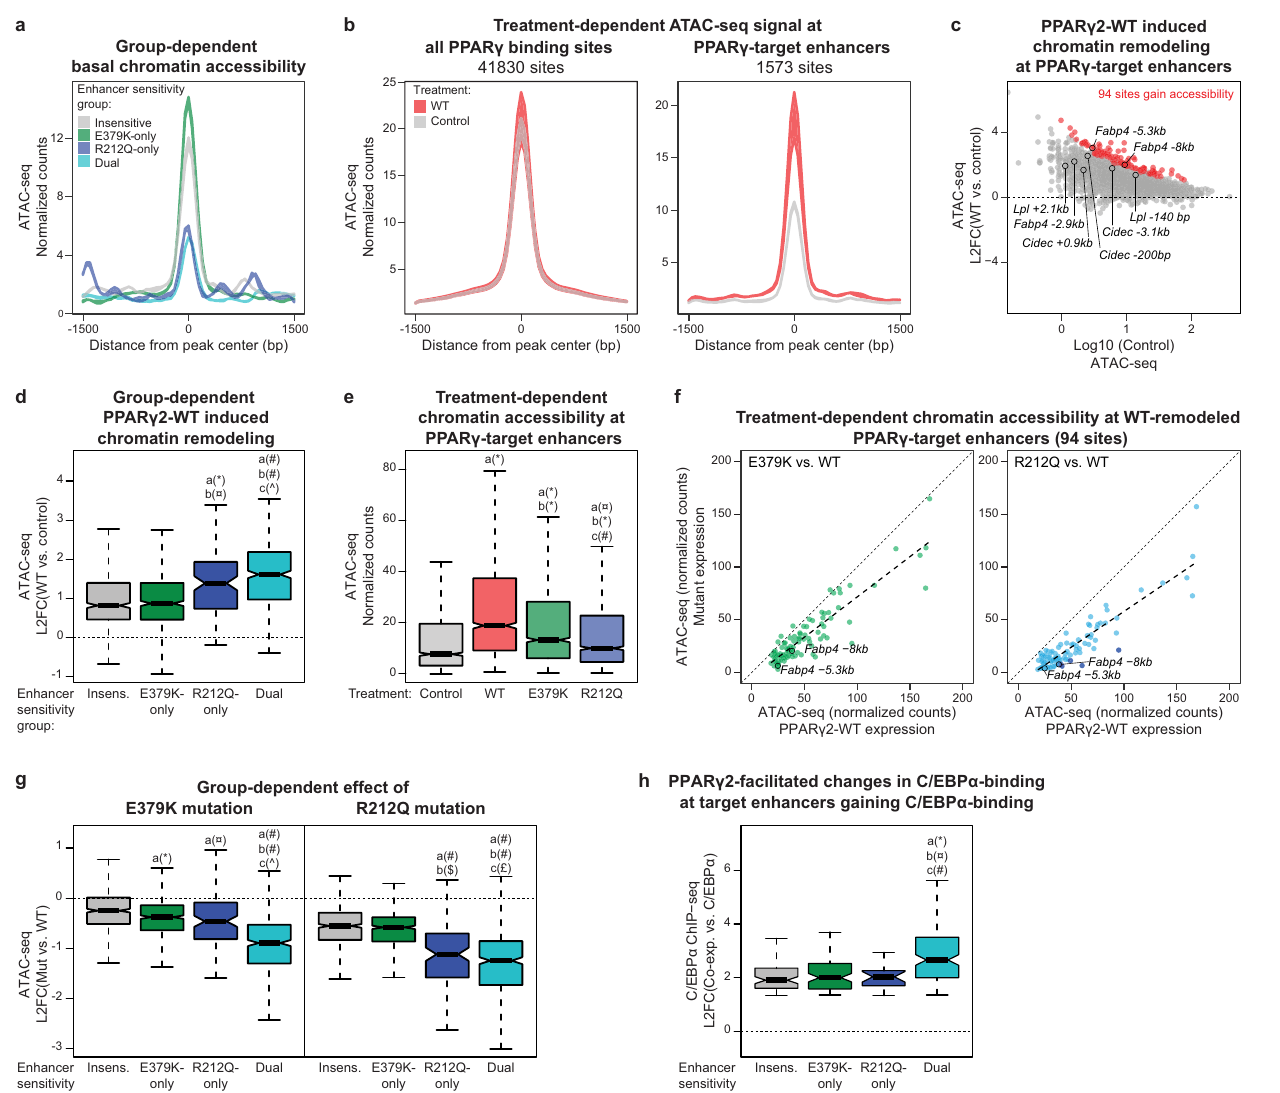
Fig. 8 | R212Q-sensitive enhancers are found in less accessible regions of the chromatin.a Enhancergroup-dependentATAC-seqsignalincontrolcells.Colored arearepresentsthedifferencebetweenthetworeplicates. b Treatment-dependent ATAC-seq signal from control and PPAR γ 2-WT expressing PPAR γ − / − MEF-CAR cells on all PPAR γ binding sites (left) or PPAR γ -target enhancers (right). Colored area represents the difference between the two replicates. c MA-plot of PPAR γ 2-WT induced chromatin accessibility at PPAR γ -target enhancers (L2FC, log2 fold change). Gained accessibility is de fi ned using DESeq2 with Benjamini – Hochberg correction, two-sided test, padj <0.05, L2FC(WT vs. control) > 0. Selected enhan- cers are indicated. d Enhancer group-dependent PPAR γ 2-WT induced chromatin remodeling. Signi fi cance was assessed by two-sided pairwise Wilcoxon rank sum tests with Benjamini – Hochberg correction, a, versus insensitive enhancer group ( n =519);b,versusE379K-onlysensitiveenhancergroup( n =520);c,versusR212Q- only sensitive enhancer group ( n =109), dual-sensitive enhancer group ( n =405), * p =1.7e-7, ¤ p =4.7e-7, # p <2e-16, ^ p =0.01. e Treatment-dependent ATAC-seq sig- nal at PPAR γ -target enhancers ( n =1573). Signi fi cance was assessed by two-sided